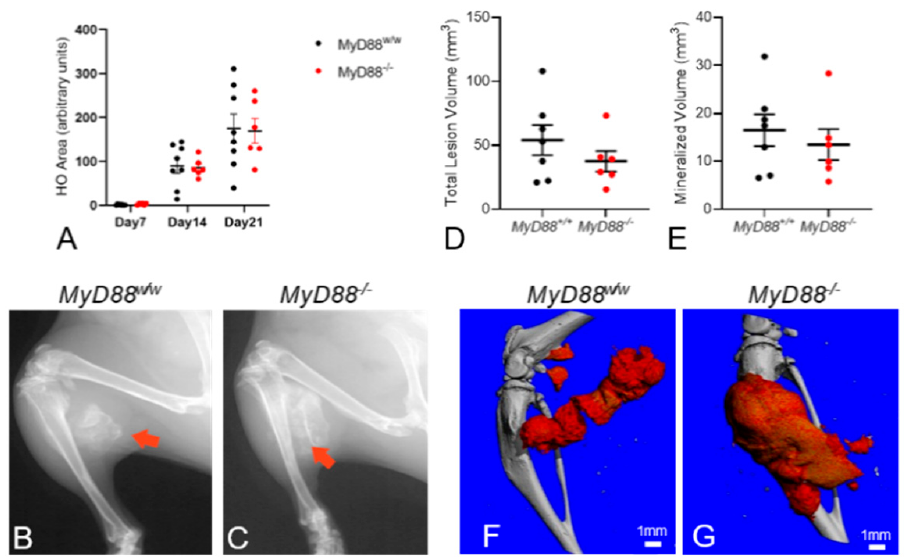
Figure 4. Global deletion of MyD88 in Acvr1 R206H_FlEx/wt FOP mice did not affect muscle injury-induced EHO lesions. ( A ) Semiquantification of intramuscular HO area in in vivo radiographs at 7, 14, and 21 dpi. µCT-based quantification of HO demonstrated that ( D ) total lesion volume and ( E ) mineralized volume were unaffected in MyD88 − / − FOP mice compared to MyD88 w/w FOP mice. Representative radiographs ( B , C ) and µCT reconstructions ( F , G ) of legs at 21 dpi in MyD88 w/w and MyD88 − / − FOP mice illustrated large intramuscular HO (red arrow and red material). Statistical significance was tested using Kruskal–Wallis test or a two-tailed unpaired Student’s t -test. No significant differences were found.